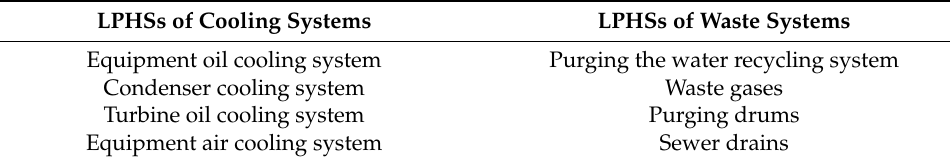
Table 3. Low-potential heat sources (LPHS) at